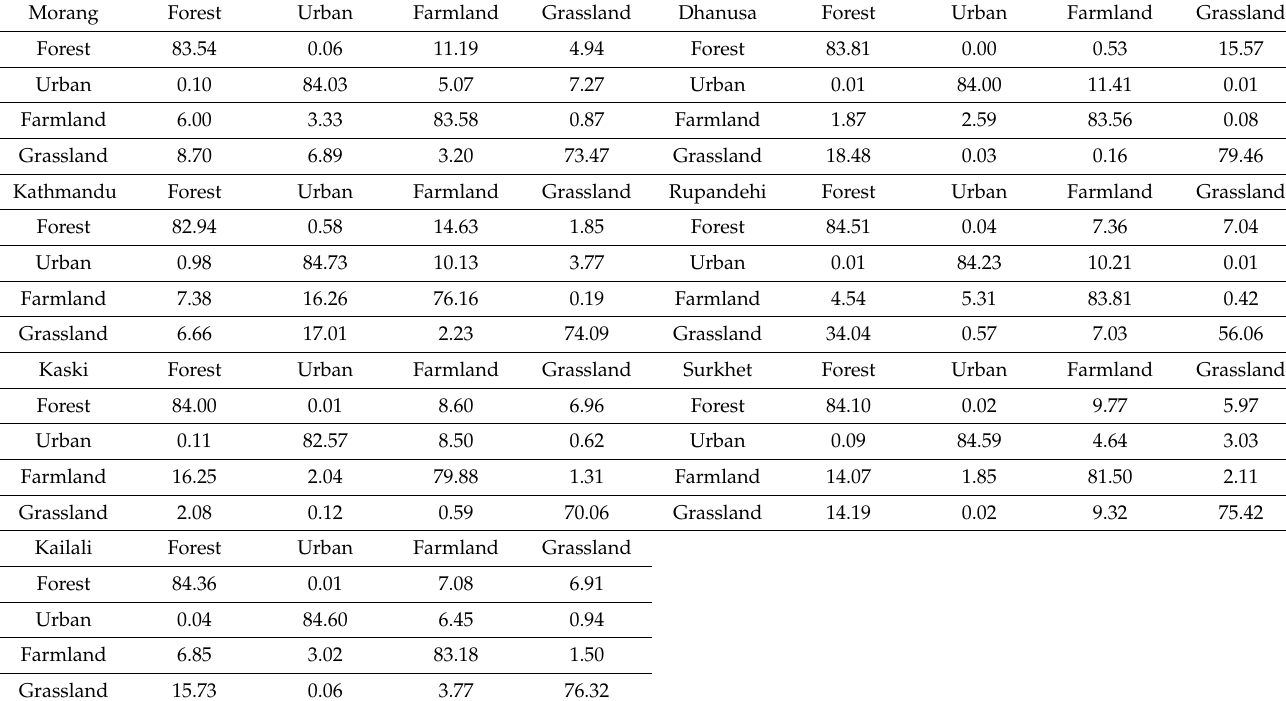
Table 5. Transition probability matrix of seven districts calculated by Markov chain (unit: %). Urban, farmland, forest and grassland are chosen from nine land cover classes of ICIMOD